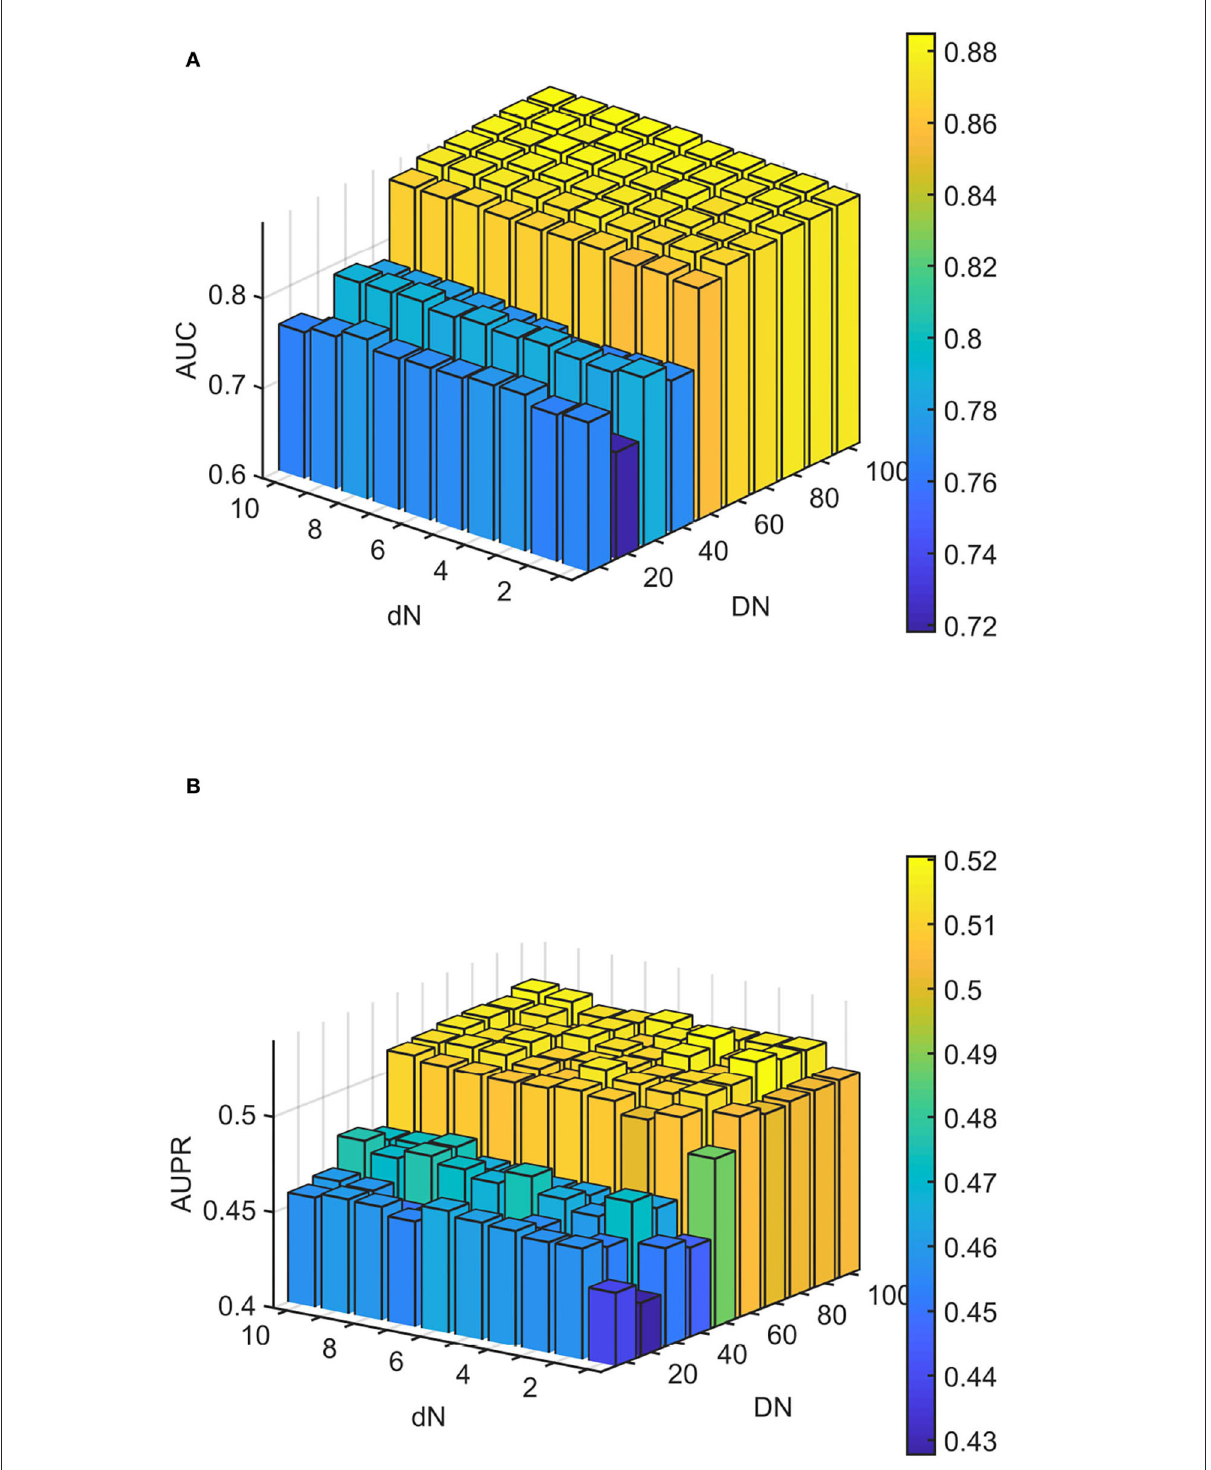
FIGURE4 Analytical plots of AUC and AUPR for DN and dN in the linear neighborhood similarity (LNS) algorithm. (A) Analytical plots of AUC for DN and dN . (B ) Analytical plots of AUPR for DN and dN